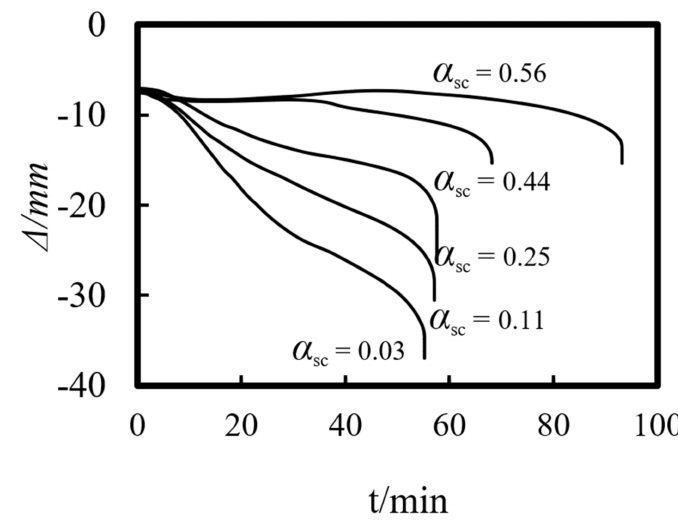
Figure 17. Effect of core area ratio on the axial deformation–time curve.